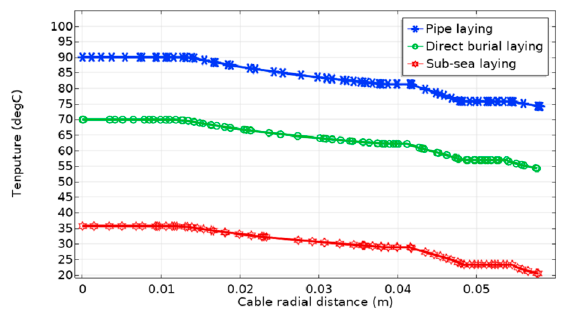
Figure 5. Radial temperature distribution curve of submarine cable for three laying methods.